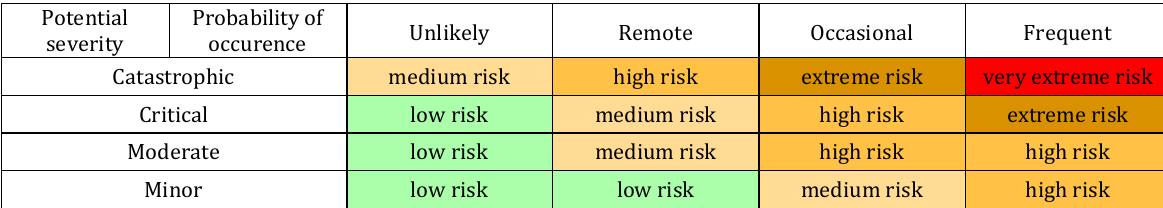
Table 1. Risk assessment matrix (based on Dominguez et al.,